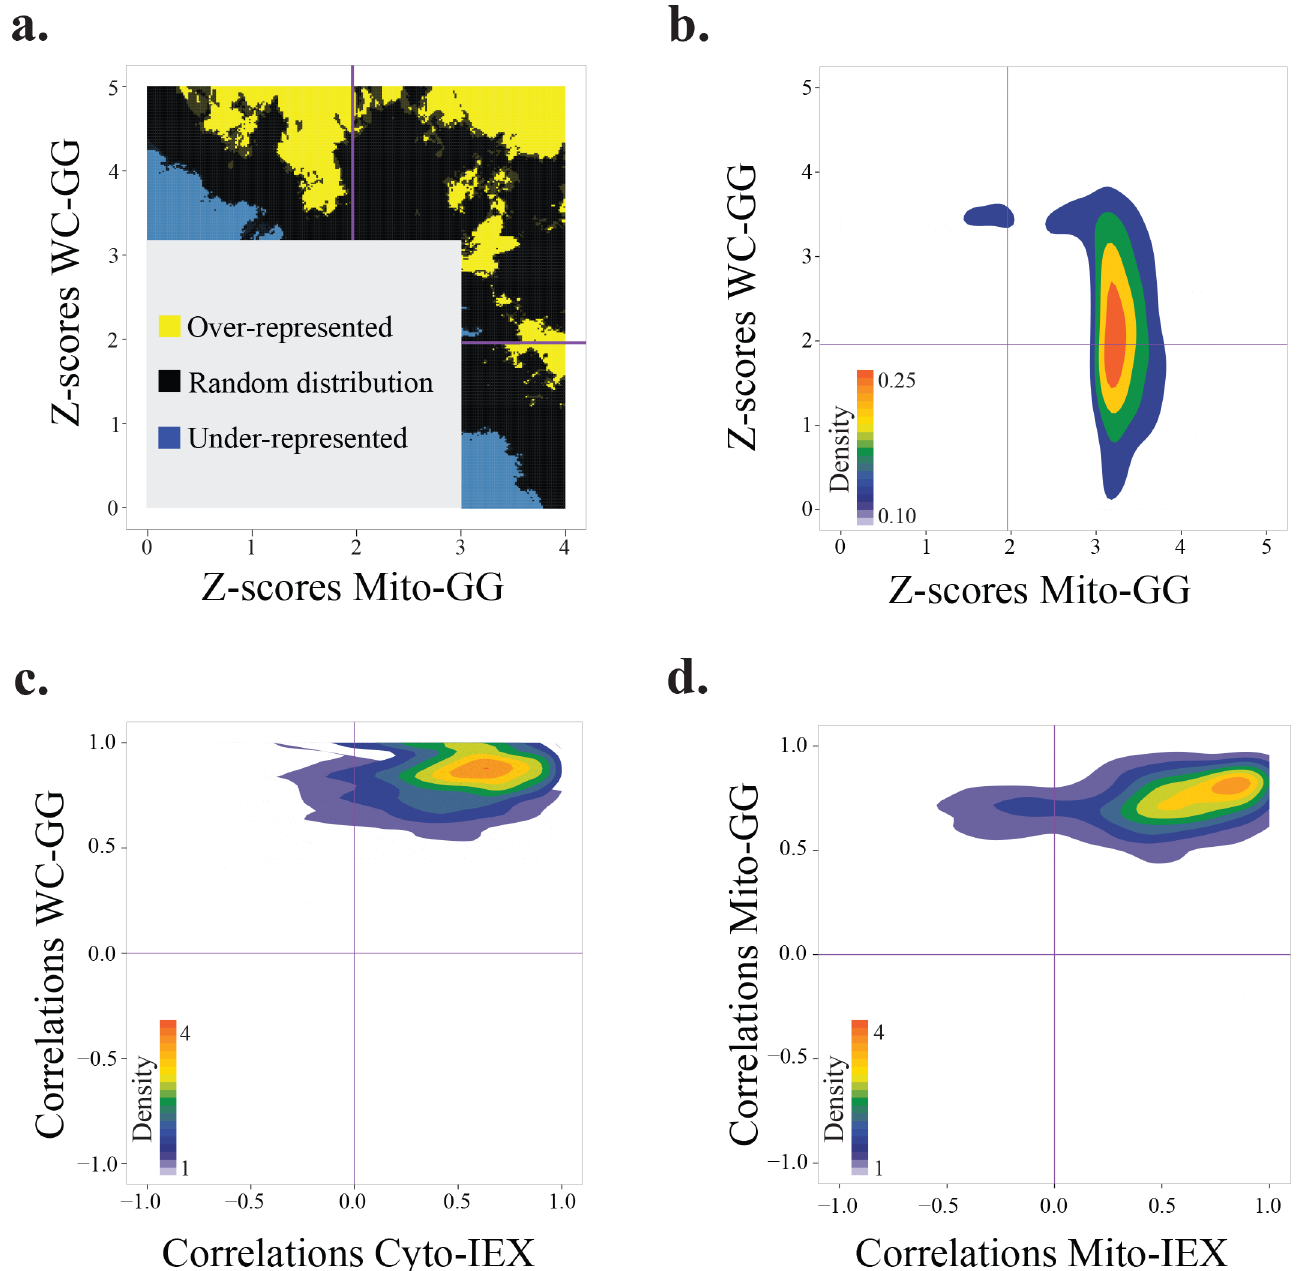
Fig 3. Validation of filtration steps used for stringent analysis of fractionation patterns. a) Interactions present in each of whole cell-GG and mitochondrial-GG networks were categorized as either shared-peak interactions (interacting proteins show a peak in at least one shared fraction) or unshared-peak interactions (interacting proteins show completely distinct peaks). Gray area represents the co-sedimentation space that was not significant in either fractionation experiment. Blue color represents the region depleted for the shared-peak interactions and the yellow region demonstrates the area for over-represented shared-peak interactions. As shown, the shared-peak interactions are highly depleted in non-reproducible regions (upper-left and lower- right regions in the graph). Enrichment at each point on the graph was calculated using a two-tailed hypergeometric test by focusing on the closest 110 interactions to that point (p-value (cid:1) 0.05). b) Distribution of z-scores for significant interactions identified in whole cell-GG and/or mitochondrial-GG experiments. The horizontal and vertical purple lines intersect with the XY-axes at points corresponding to the p-value equal to 0.05. As illustrated, more than half of interactions fall in the region that is significant in both experiments (upper-right region). c) Distribution of correlations for significant interactions identified in either whole cell-GG (WC-GG) or cytosolic-IEX (Cyto-IEX) datasets. As shown, interactions have clear peak (color coded in red) in the highly reproducible region (upper-right region). d) Distribution of correlations for significant interactions identified in either mitochondrial-GG (Mito-GG) or mitochondrial-IEX (Mito-IEX) datasets. As shown, interactions have clear peak (color coded in red) in the highly reproducible region (upper-right region).